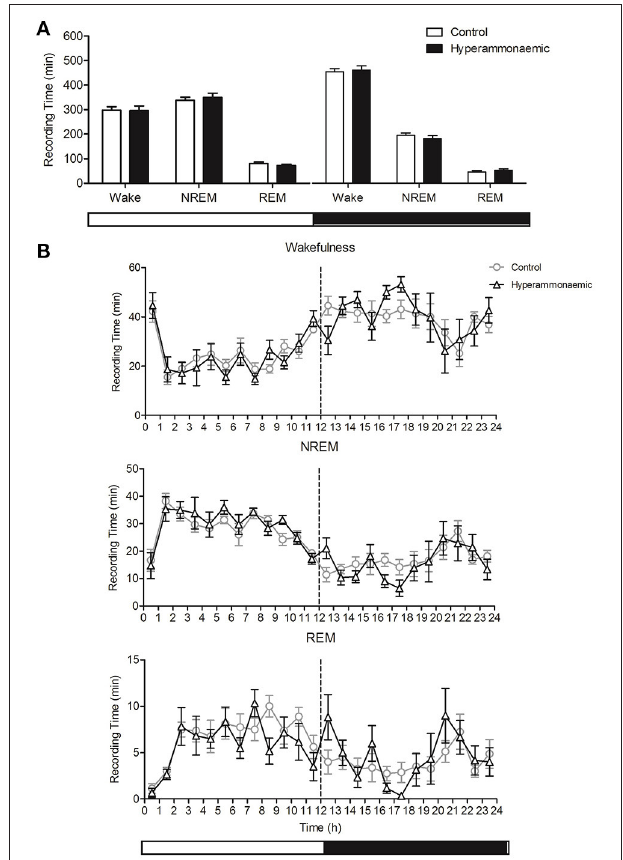
FIGURE 3 | (A) Comparison of the total time (min) spent in Wake-NREM-REM state, in the light (left) and dark (right) period, between control (white bars) and hyperammonemic (black bars) animals, during the spontaneous sleep-wake cycle. (B) Comparison of Wakefulness, NREM and REM sleep profile (min/hour) between control (circles) and hyperammonemic (triangles) animals, during the spontaneous sleep-wake